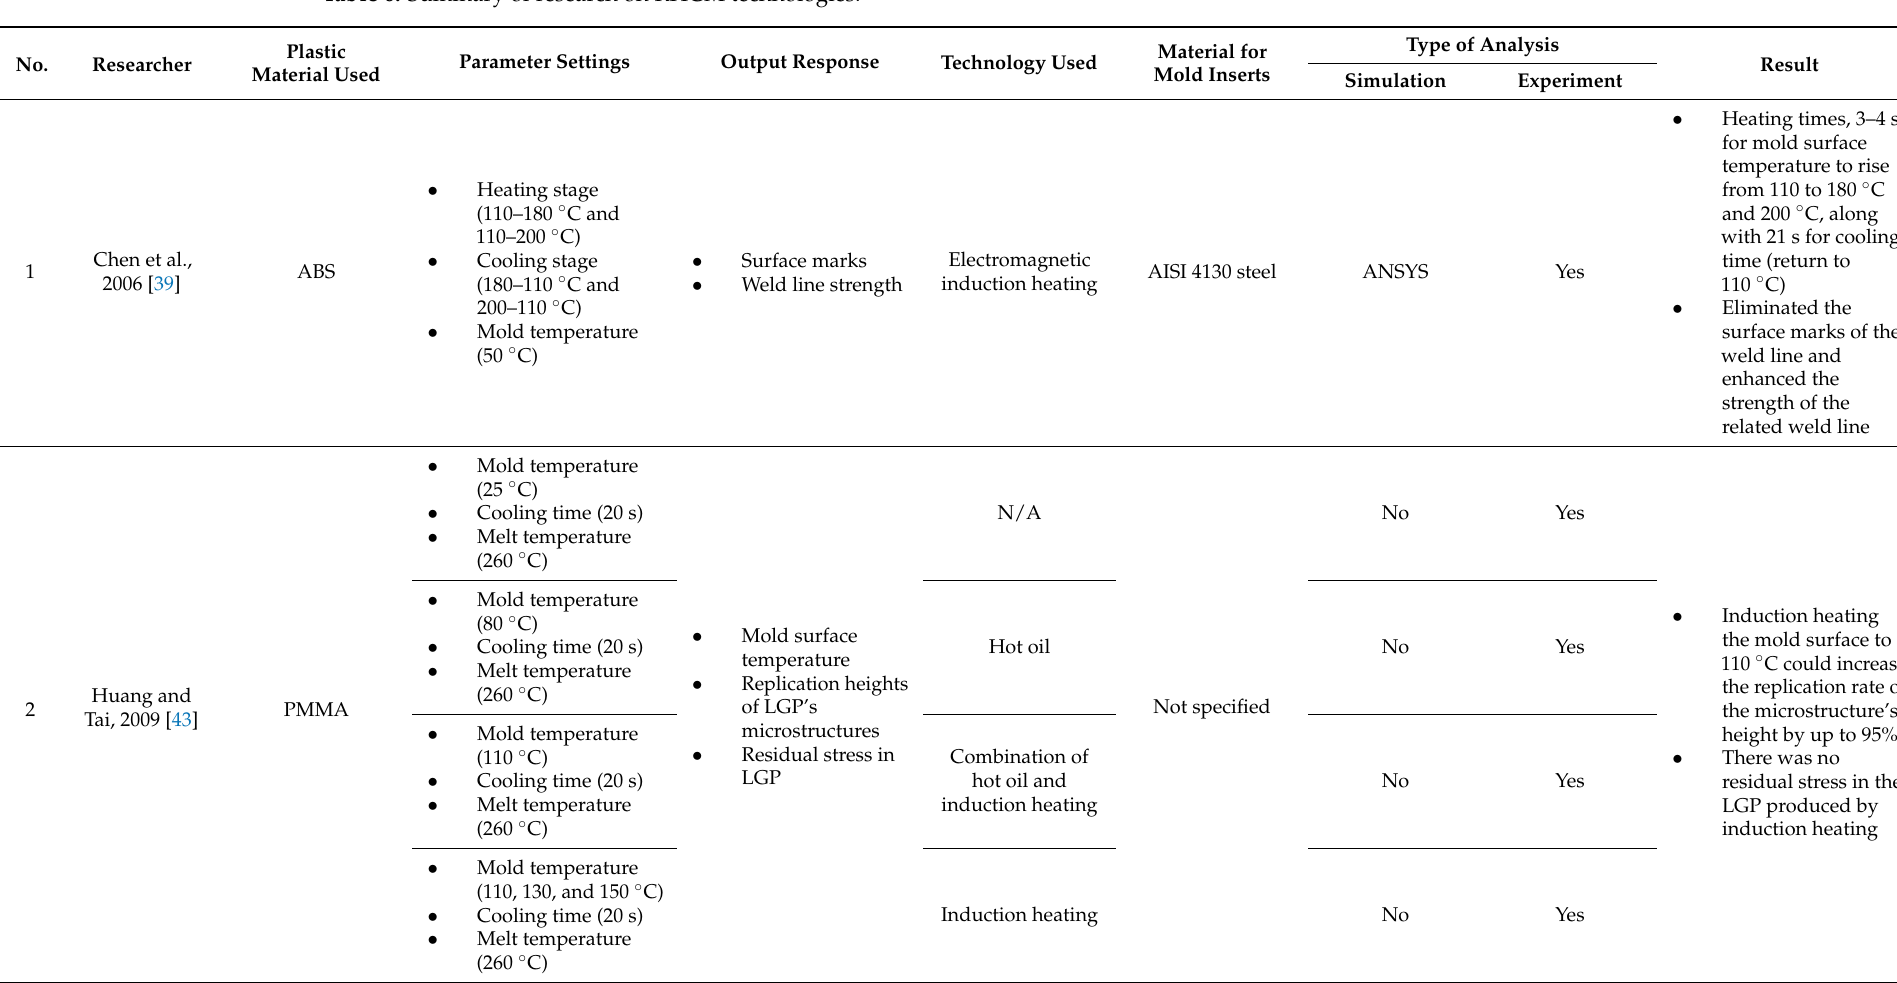
Table 6. Summary of research on RHCM